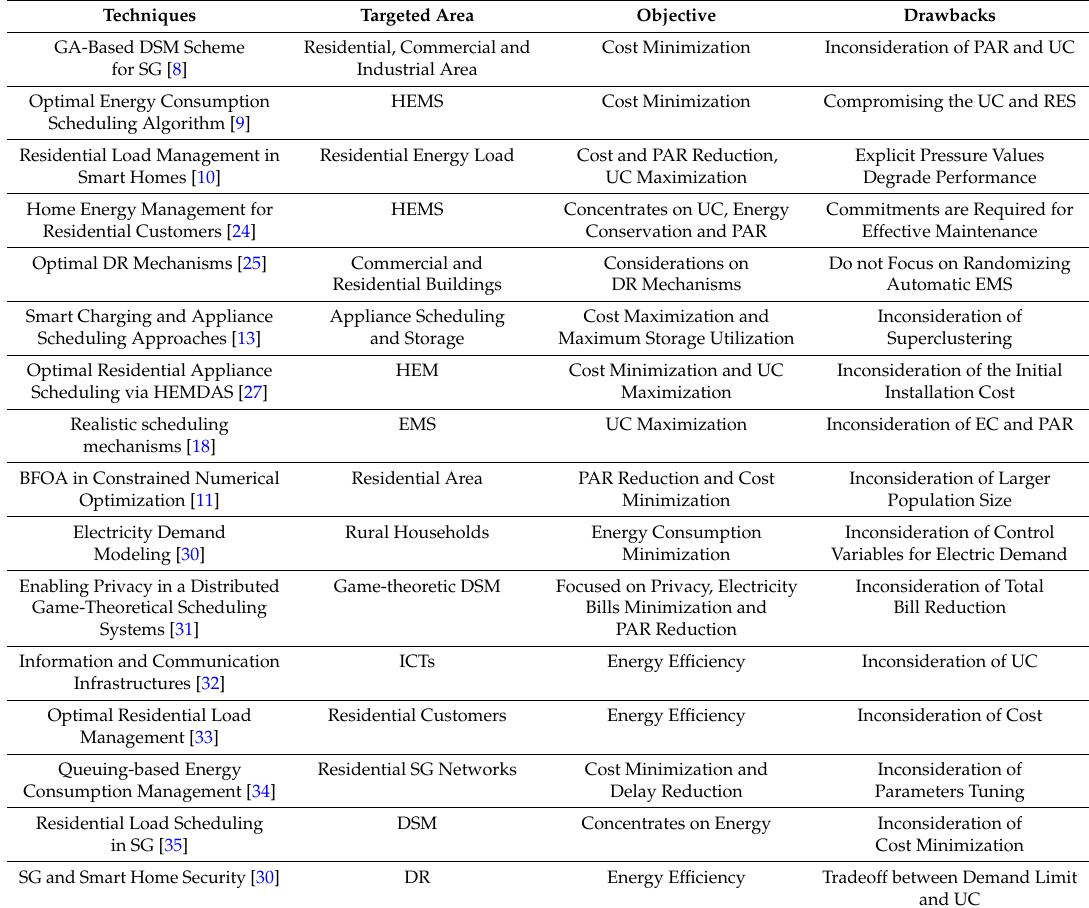
Table 3. Recent trends: state of the art